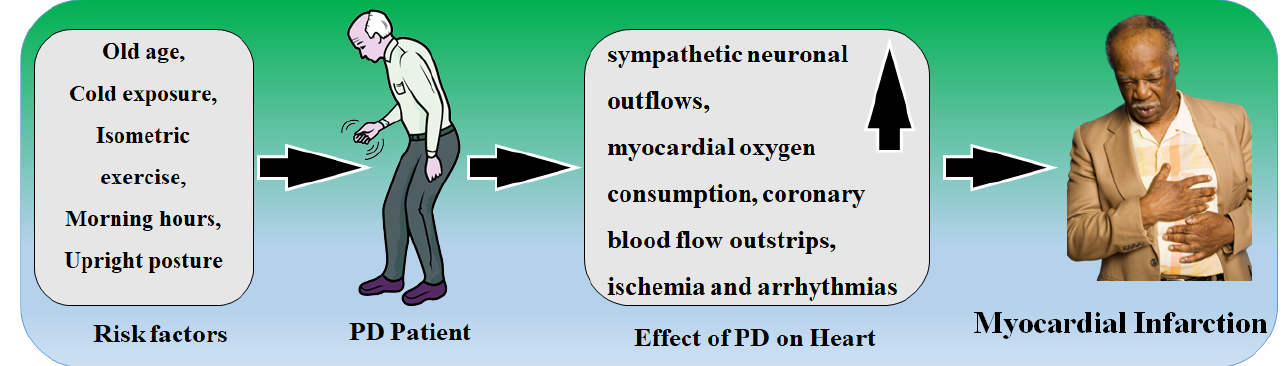
Figure 3. A risk factor in PD patients responsible for myocardial infarction.